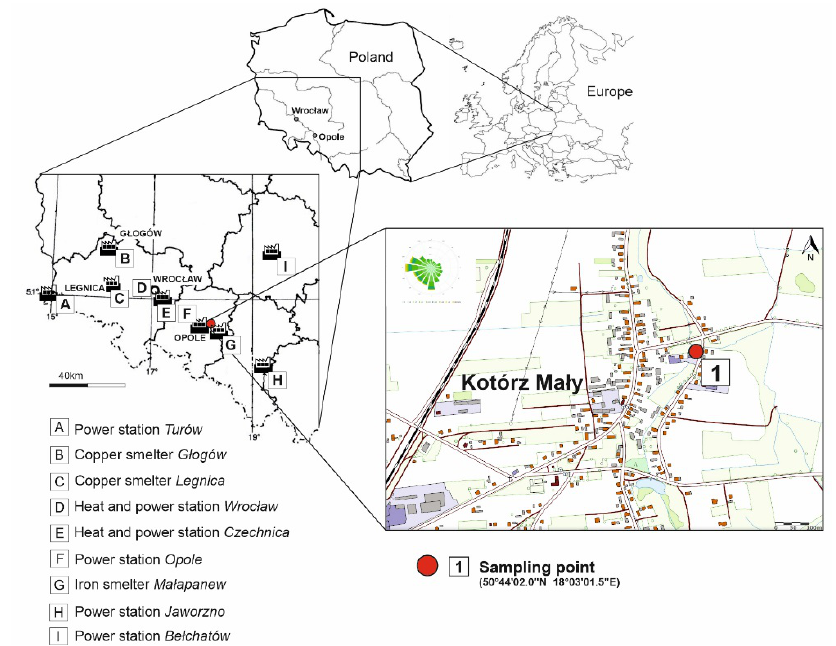
Figure 1. Location of the study area .